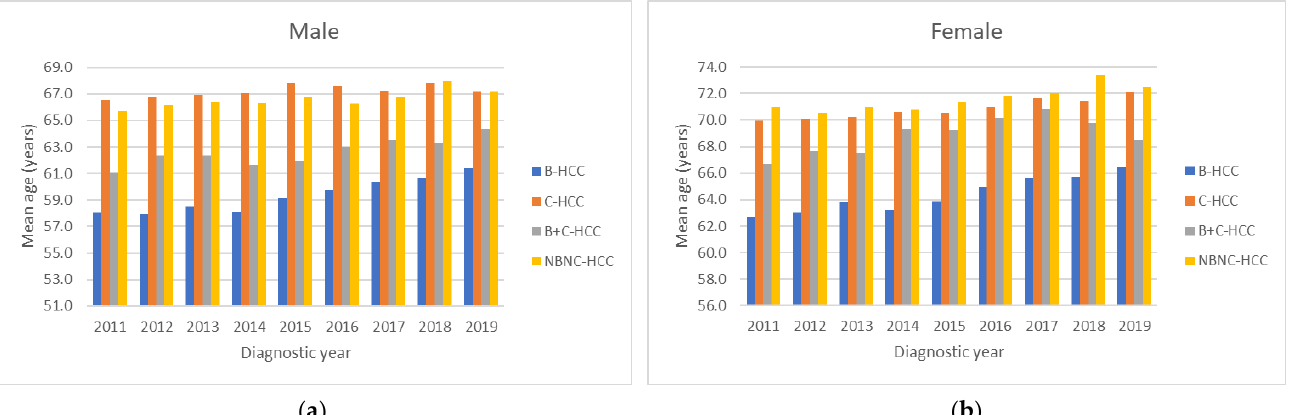
Figure 4. All mean ages during the time period classified according to gender and viral etiology showed increasing trends in both male ( a ) and female ( b ) gender (all p values for linear trend <0.01).